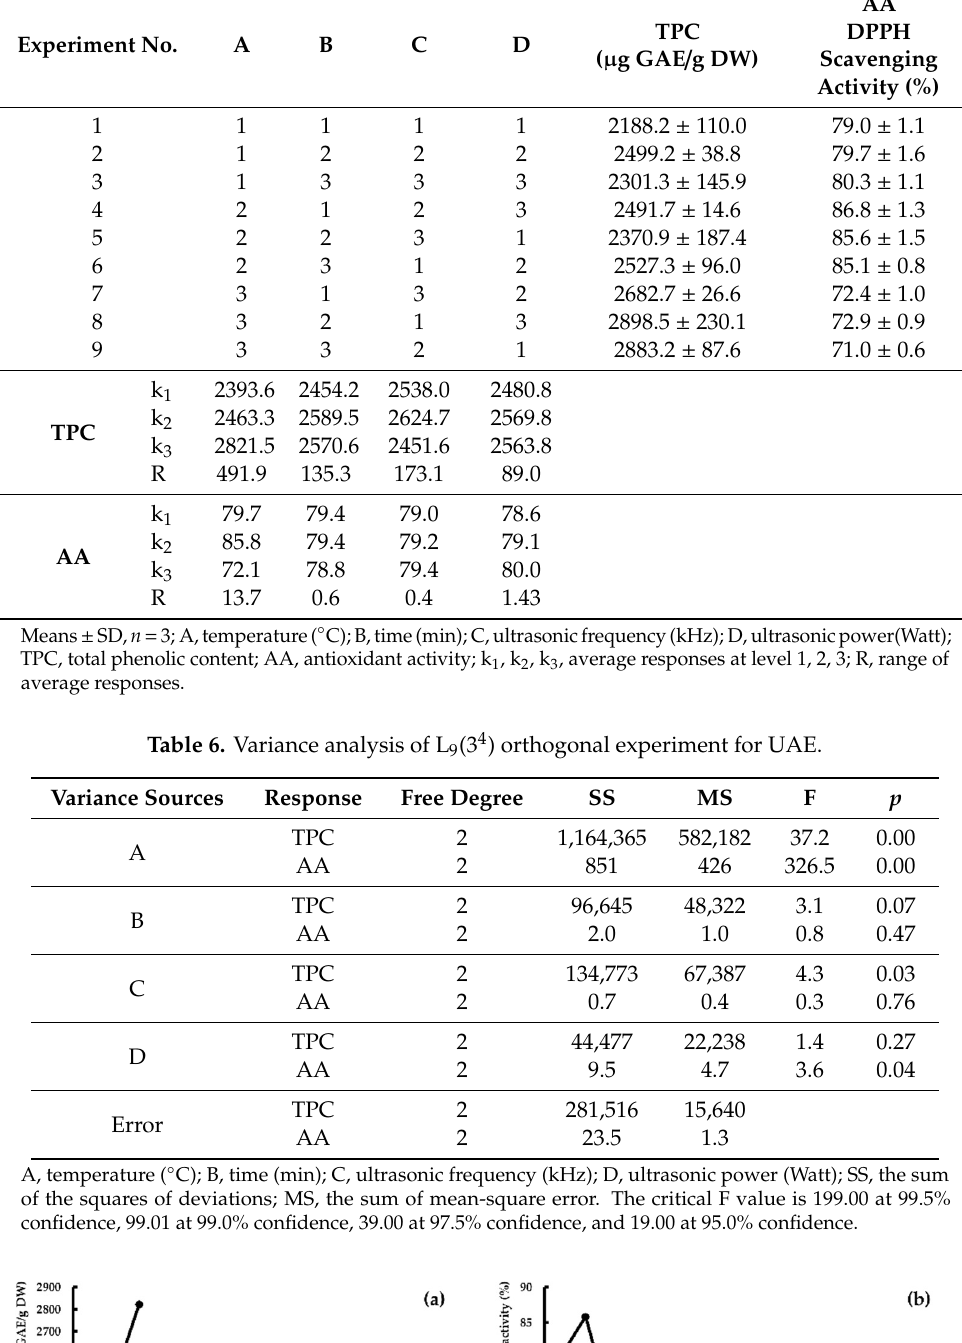
Table 6. Variance analysis of L 9 (3 4 ) orthogonal experiment for UAE. Variance Sources